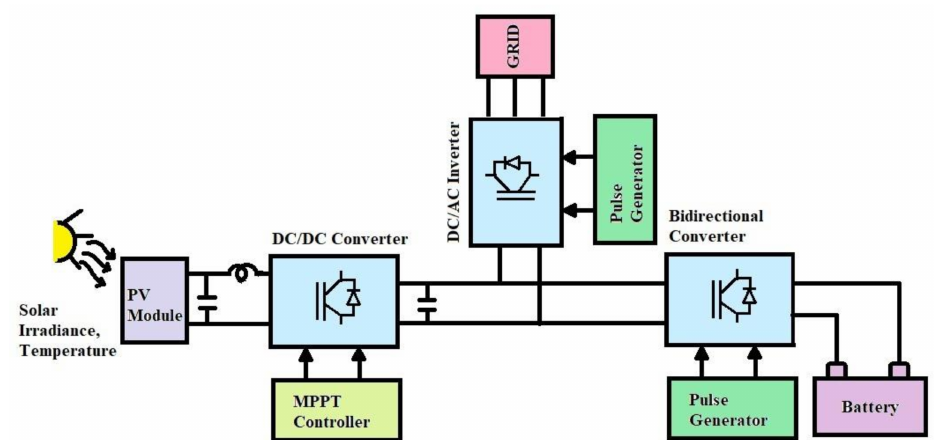
Figure 8. Vehicle to grid